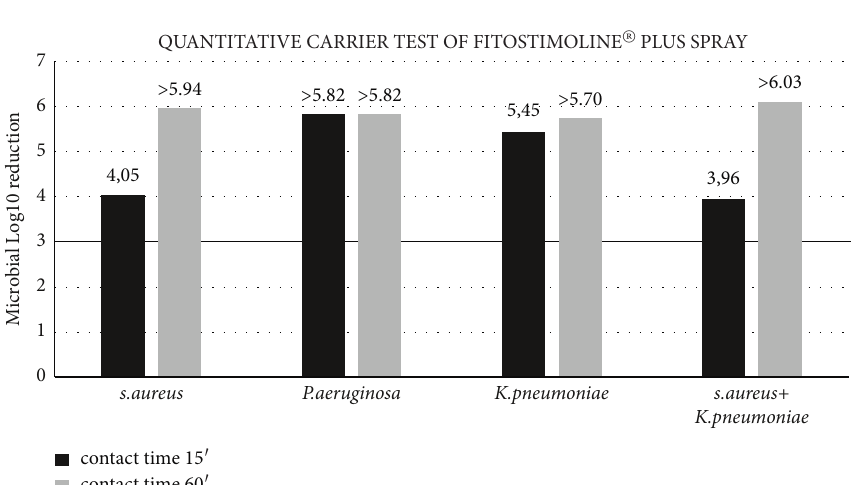
Figure 3: Antimicrobial activity of one pump (duration: 3 seconds) of Fitostimoline ® Plus spray for two different contact times (15 and 60 minutes) against S. aureus , P. aeruginosa , K. pneumoniae , and a mix of S. aureus and K. pneumoniae on glass carriers in the presence of FBS. The results are expressed as microbial log10 reduction measured in terms of remaining colony-forming units (CFUs) on the glass carrier after the product’s action. The horizontal black limit line indicates 99.9% bacteria